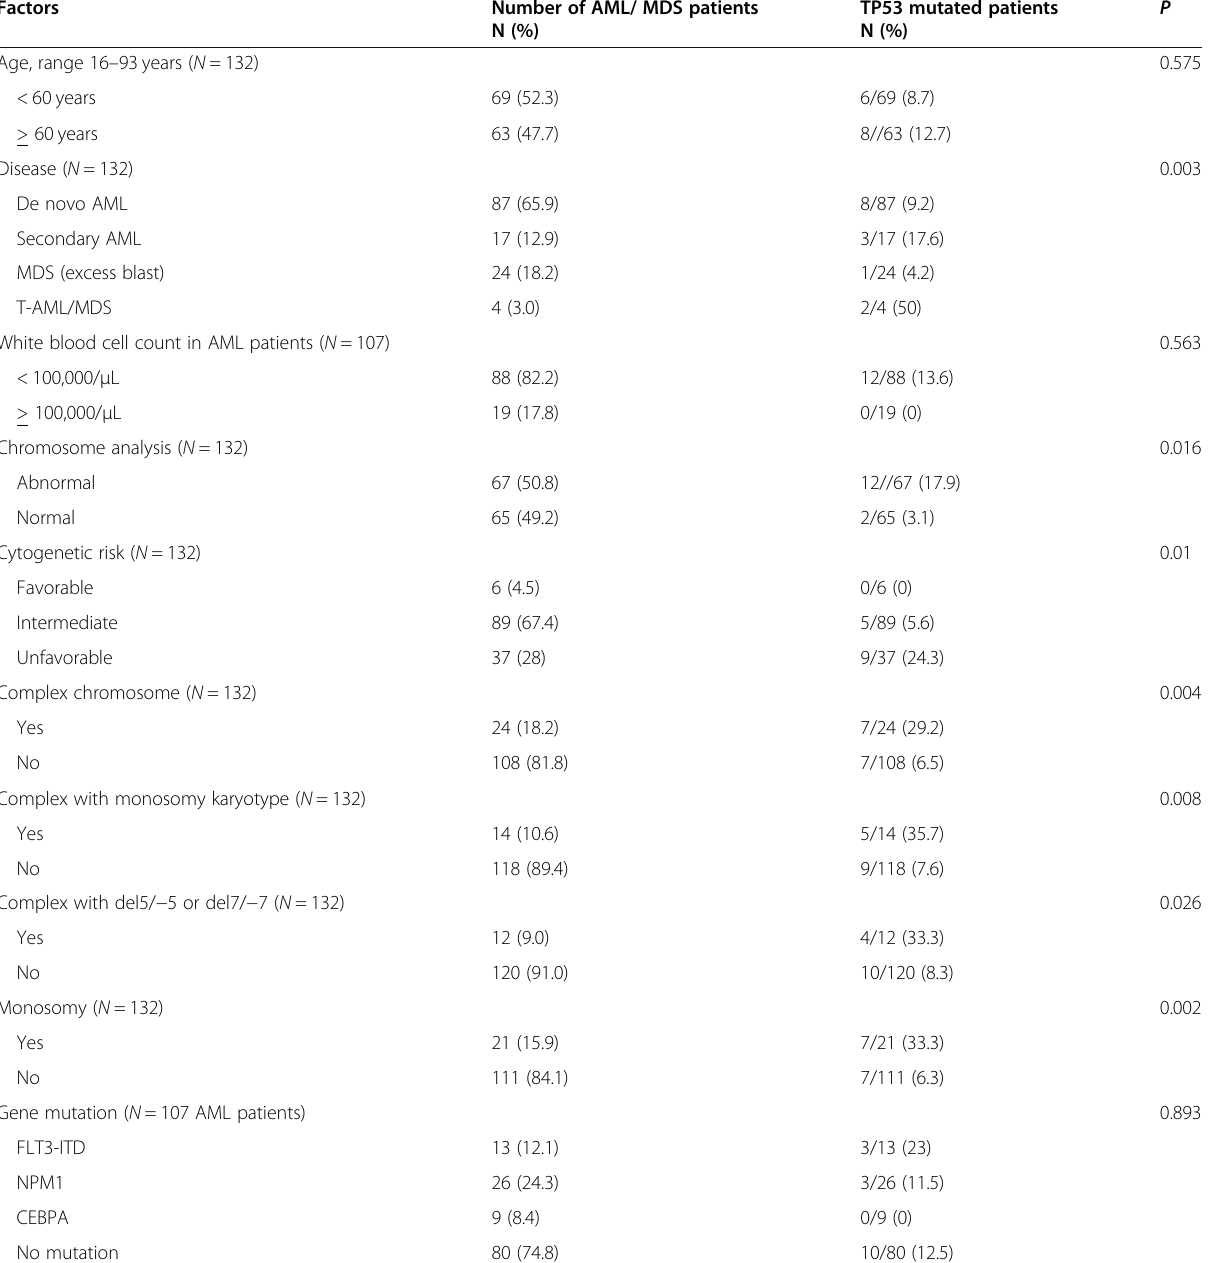
Table 1 Patients ’ characteristics and TP53 mutation in 132 patients with AML/ MDS Factors Number of AML/ MDS patients